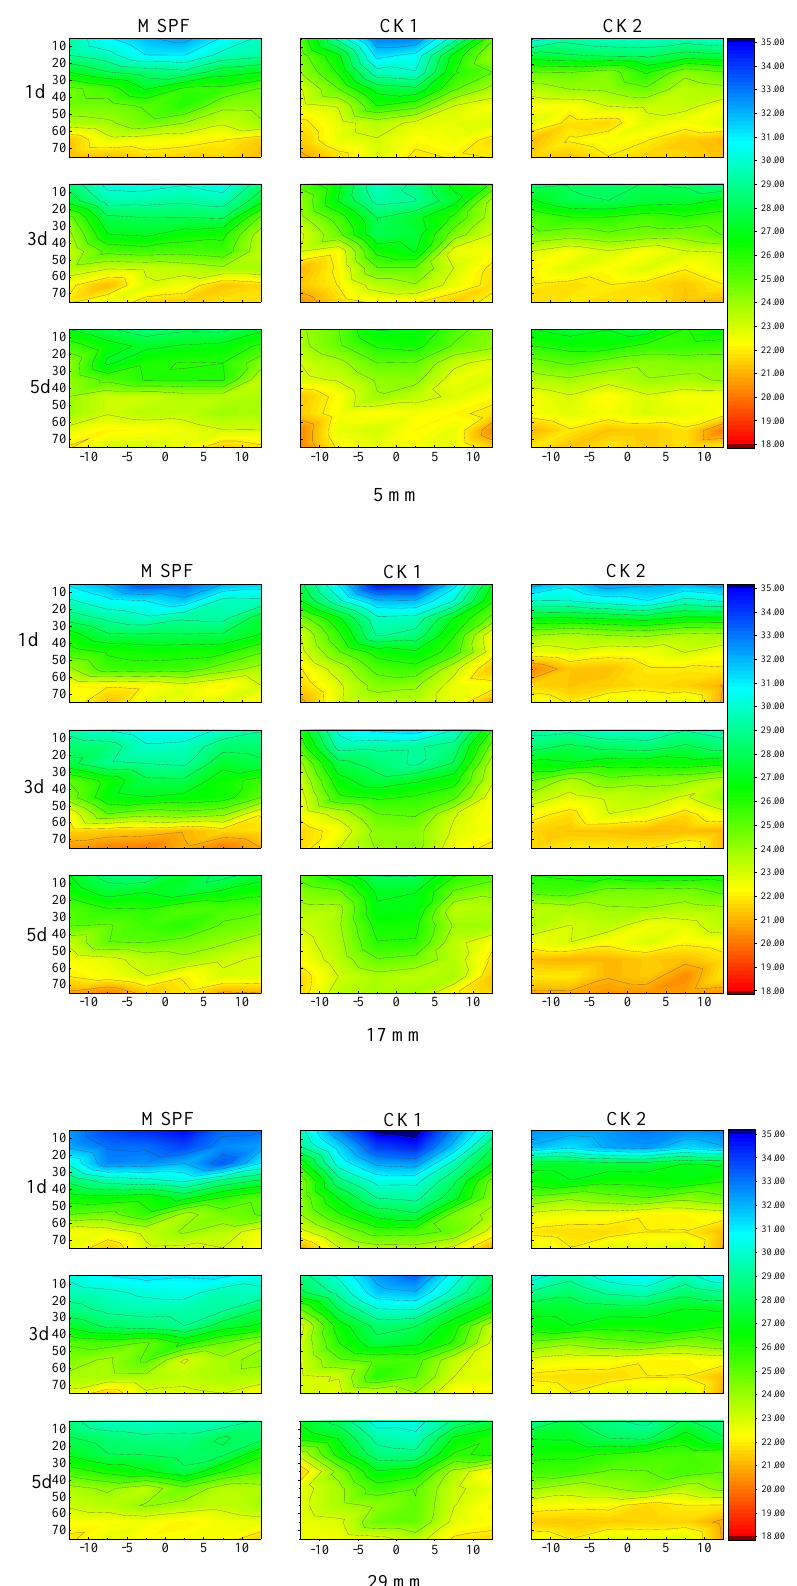
Figure 3. Dynamic movement of soil water under different treatments. Note: the 5, 17, and 29 mm represents irrigation amount, mm; the 1, 3, and 5 d represents days after irrigation, d; the vertical coordinate represents soil volume moisture content, %; and the horizontal axis represents distance from outflow micropore (emitter) distance,